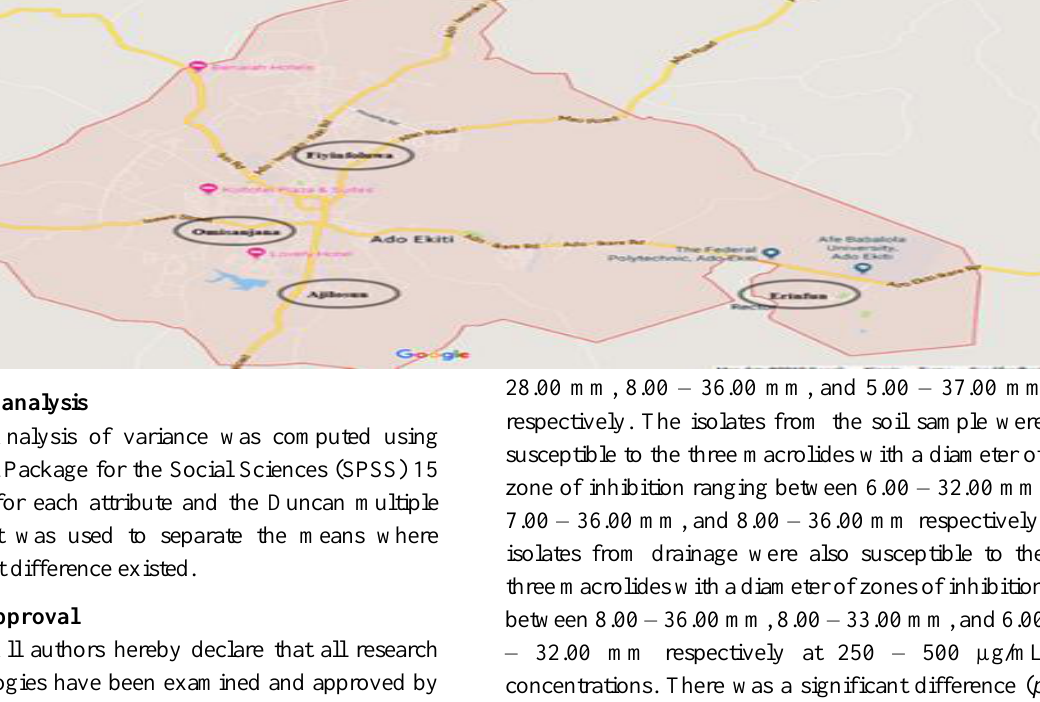
Figure 1. Map of Ado-Ekiti showing the study areas